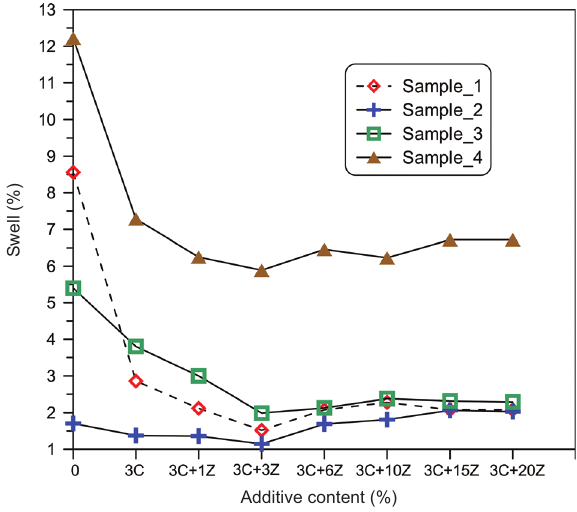
Figure 5 Relationship between additive content and swell percentage of the soil samples.